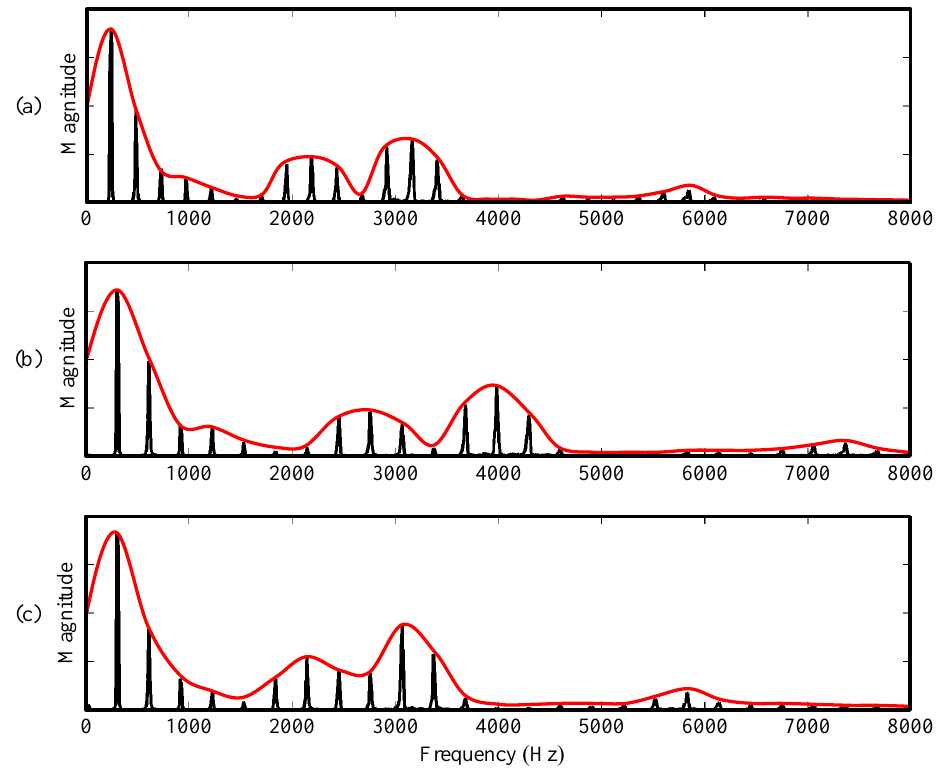
Figure 17. Frequency spectra for a fixed frame m of different versions of a singing voice recording. The spectral envelopes are marked in red. ( a ) Original spectrum X ( m ) with spectral envelope Γ m ; ( b ) Pitch-shifted spectrum X Shift ( m ) with spectral envelope Γ Shift m ; ( c ) Pitch-shifted spectrum X Mod ( m ) with adapted spectral